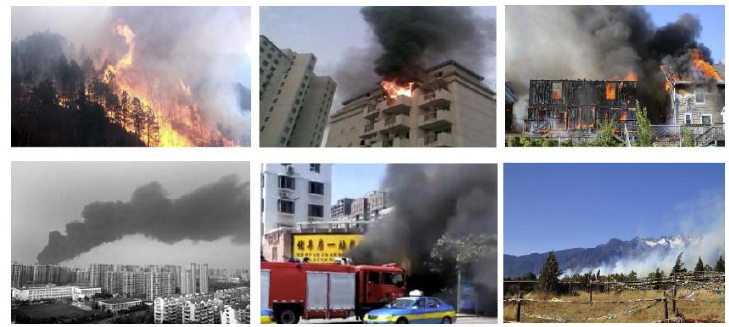
Figure 11. Examples of images from the dataset used in the